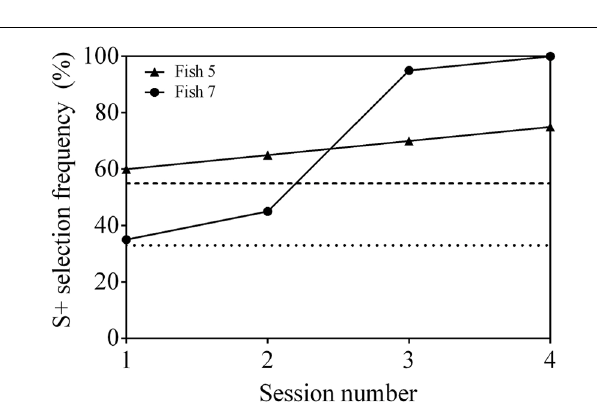
FIGURE 5 | Discrimination performance as a function of time (binned by testing session), indicating the steady improvement observed for two fish carrying out the 3-AFC task. Fish 5 and 7 were trained to select S1 and S2, respectively ( Table 1